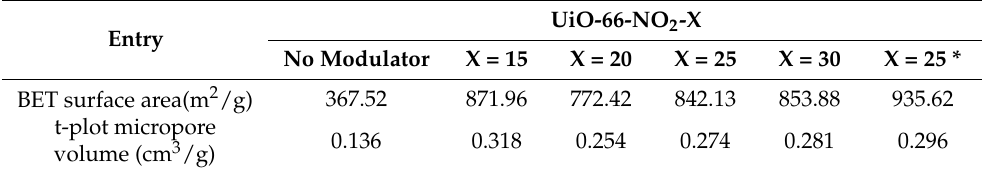
Table 3. Analysis of nitrogen adsorption isotherms of UiO-66-NO 2 -X.